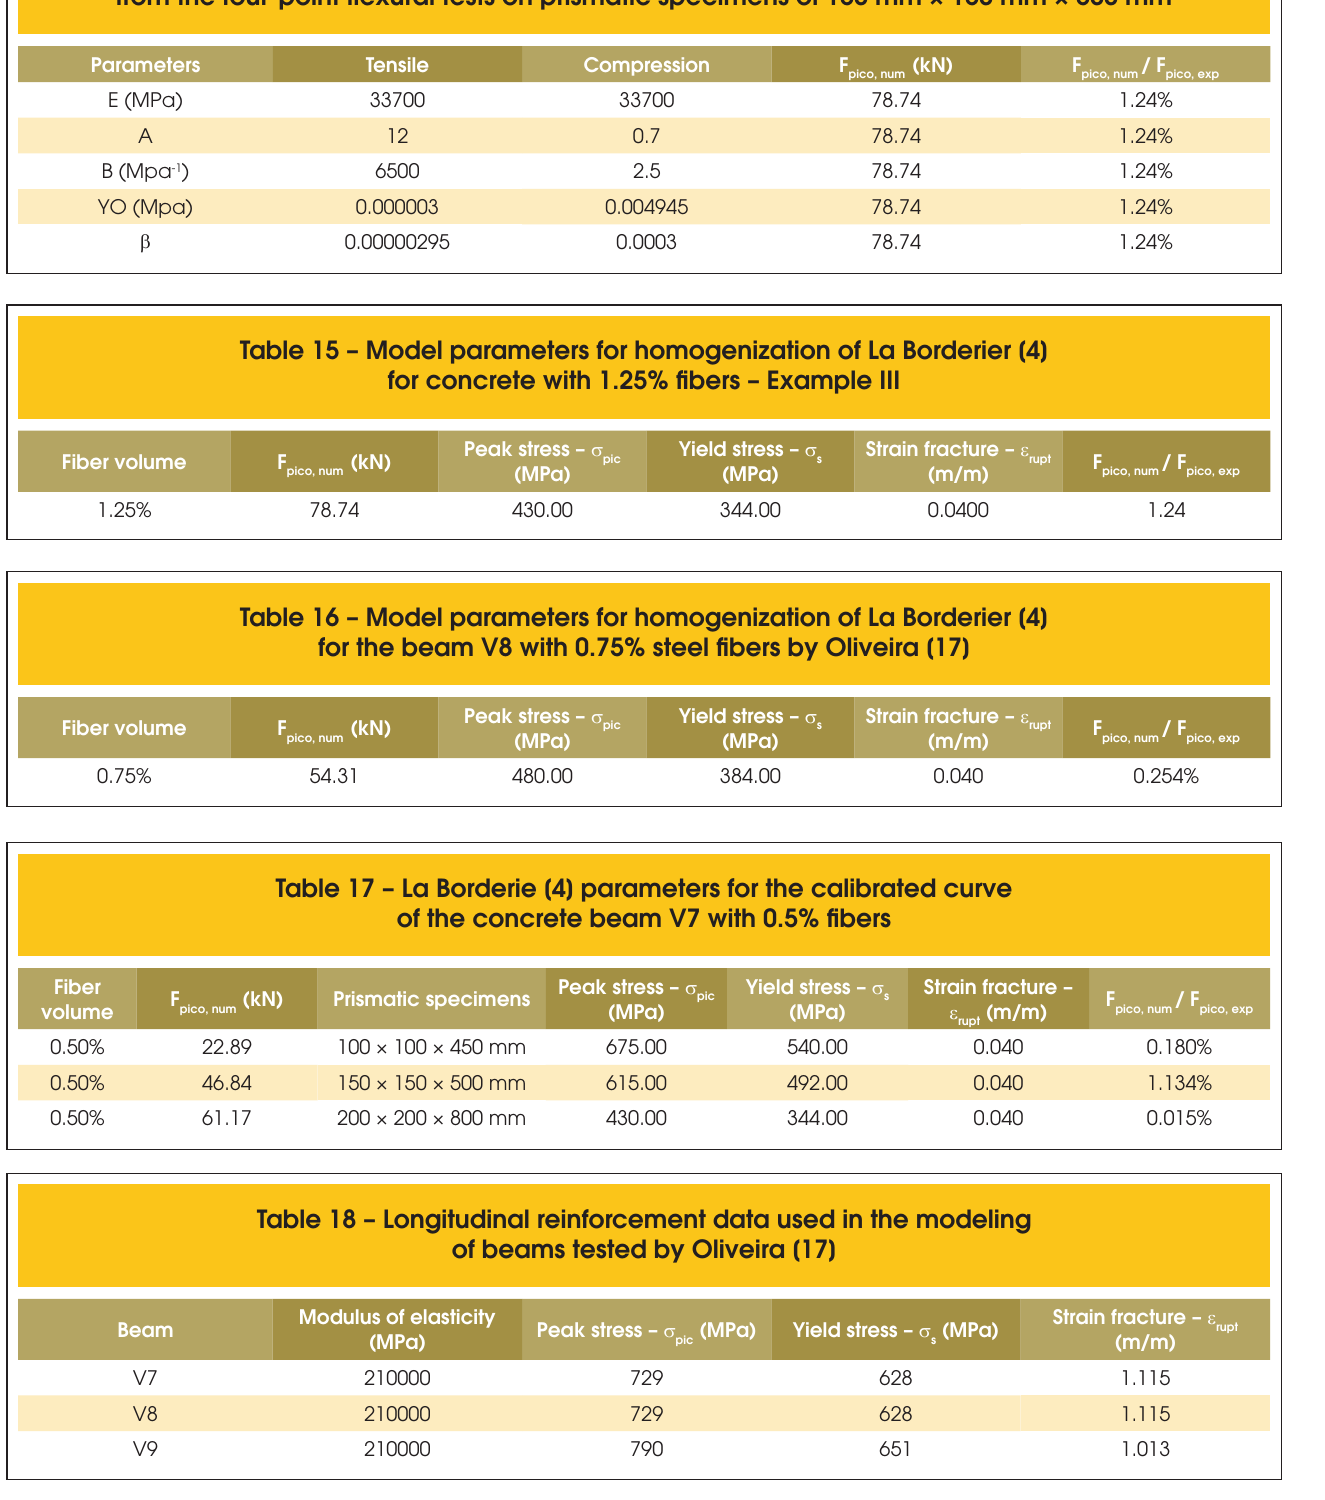
Table 14 – Damage parameters and elastic modulus of concrete without fibers identified from the four-point flexural tests on prismatic specimens of 150 mm × 150 mm × 500 mm